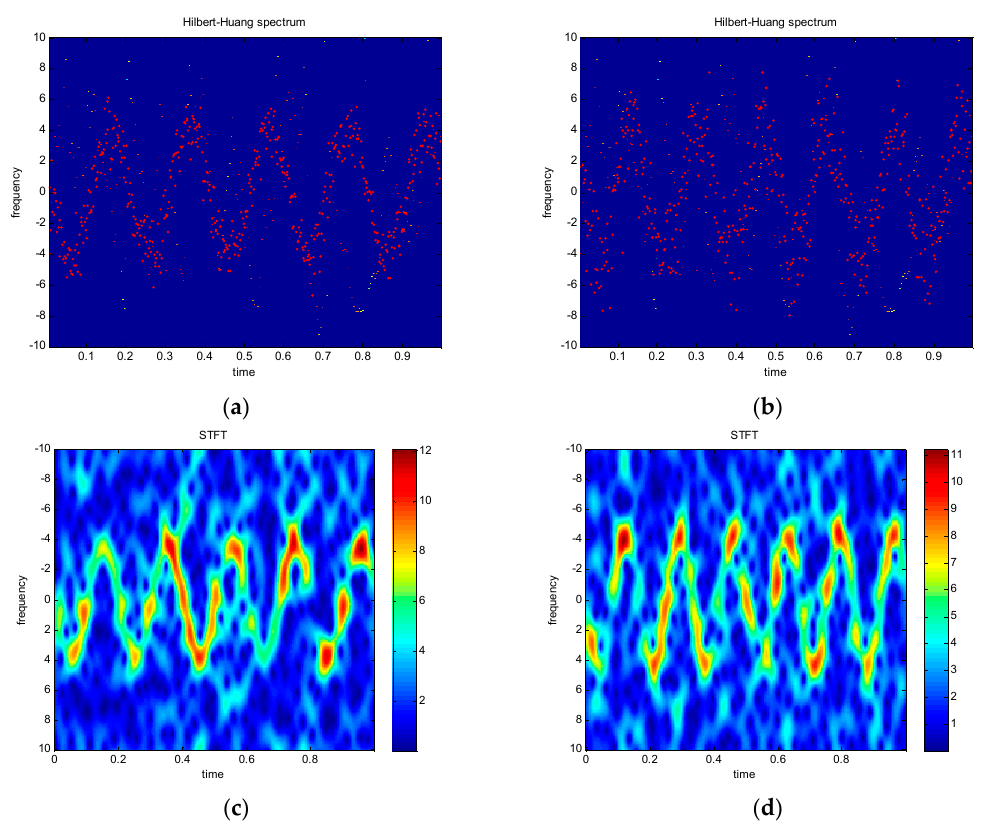
Figure 7. The results of AMD decomposition of IMF1: ( a , b ) HH spectrum of AMD1 and AMD2; ( c , d ) STFT of AMD1 and AMD2.